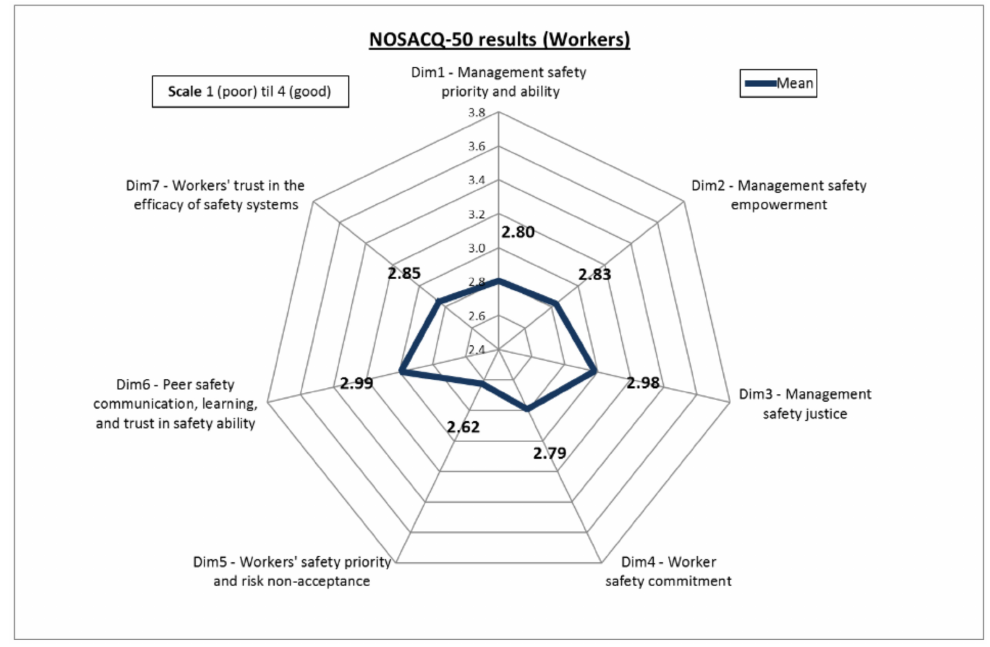
Figure 4. Overall scores obtained by workers.